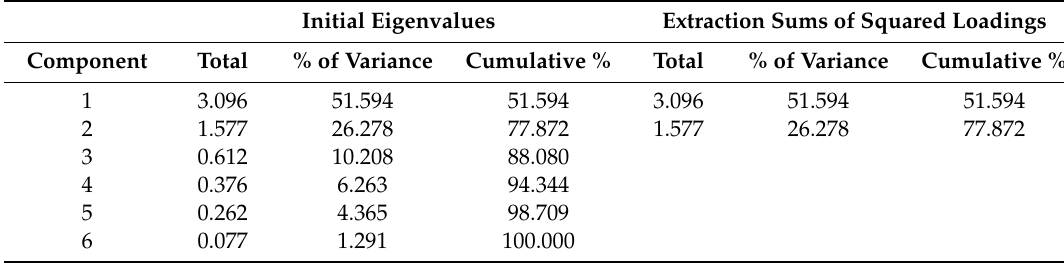
Table 2. Results of factor